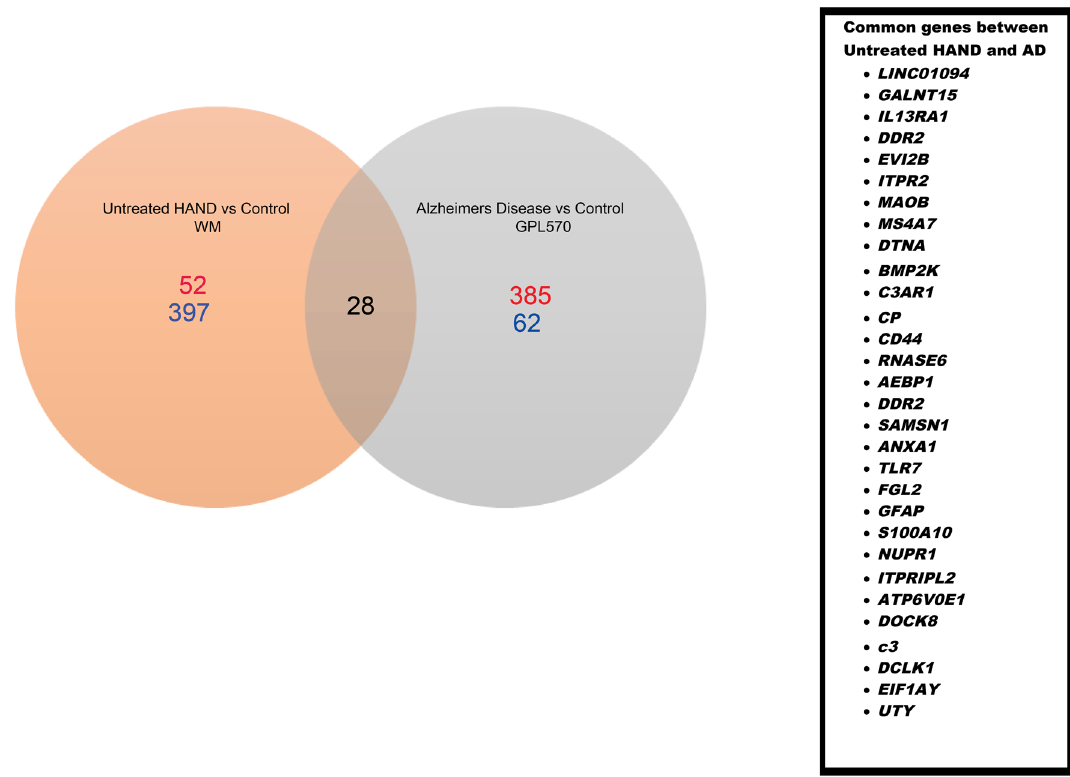
Figure 8. SAM results in comparison of untreated HAND and AD patients (nucleus accumbens/amygdala). This Venn diagram represents the SAM results that were considered significant (q-value = < .05). Both SAM analyses were done independently and then compared. The white matter of untreated HAND patients had a total of 397 upregulated genes (blue) and 52 downregulated genes (red). The nucleus accumbens and amygdala of AD patients resulted in 62 upregulated genes (blue) and 385 downregulated genes